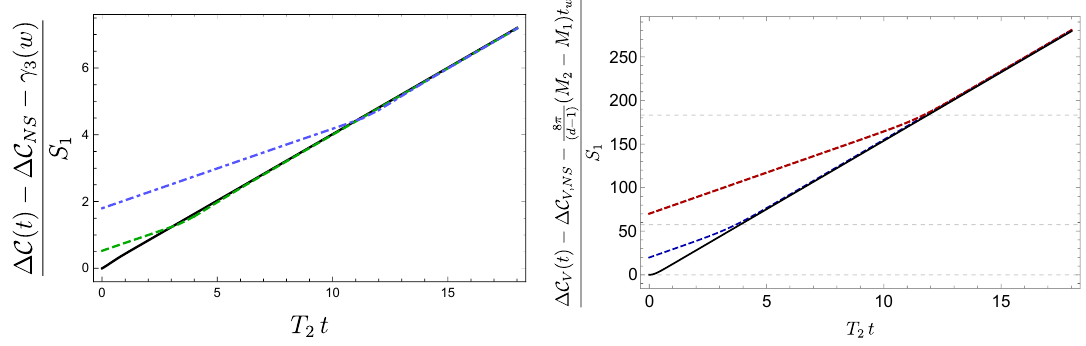
Figure 24. Complexity evolution in d = 2 for heavy shock waves. Left: using the CA proposal for w = 2 and ~ ‘ ct = 1. We show the full complexity pro(cid:12)le for two di(cid:11)erent times, T 2 t w = 2 (dashed green), T 2 t w = 6 (dot-dashed light blue). Right: time evolution of complexity using the volume conjecture for w = 2. The unperturbed evolution of an eternal BH of mass 1 in black and the evolution in the presence of the shock is in dashed colored lines for T 2 t w = 6 (red), T 2 t w = 2 (blue). The shift between the curves is proportional to ( M 2 prediction of eq.